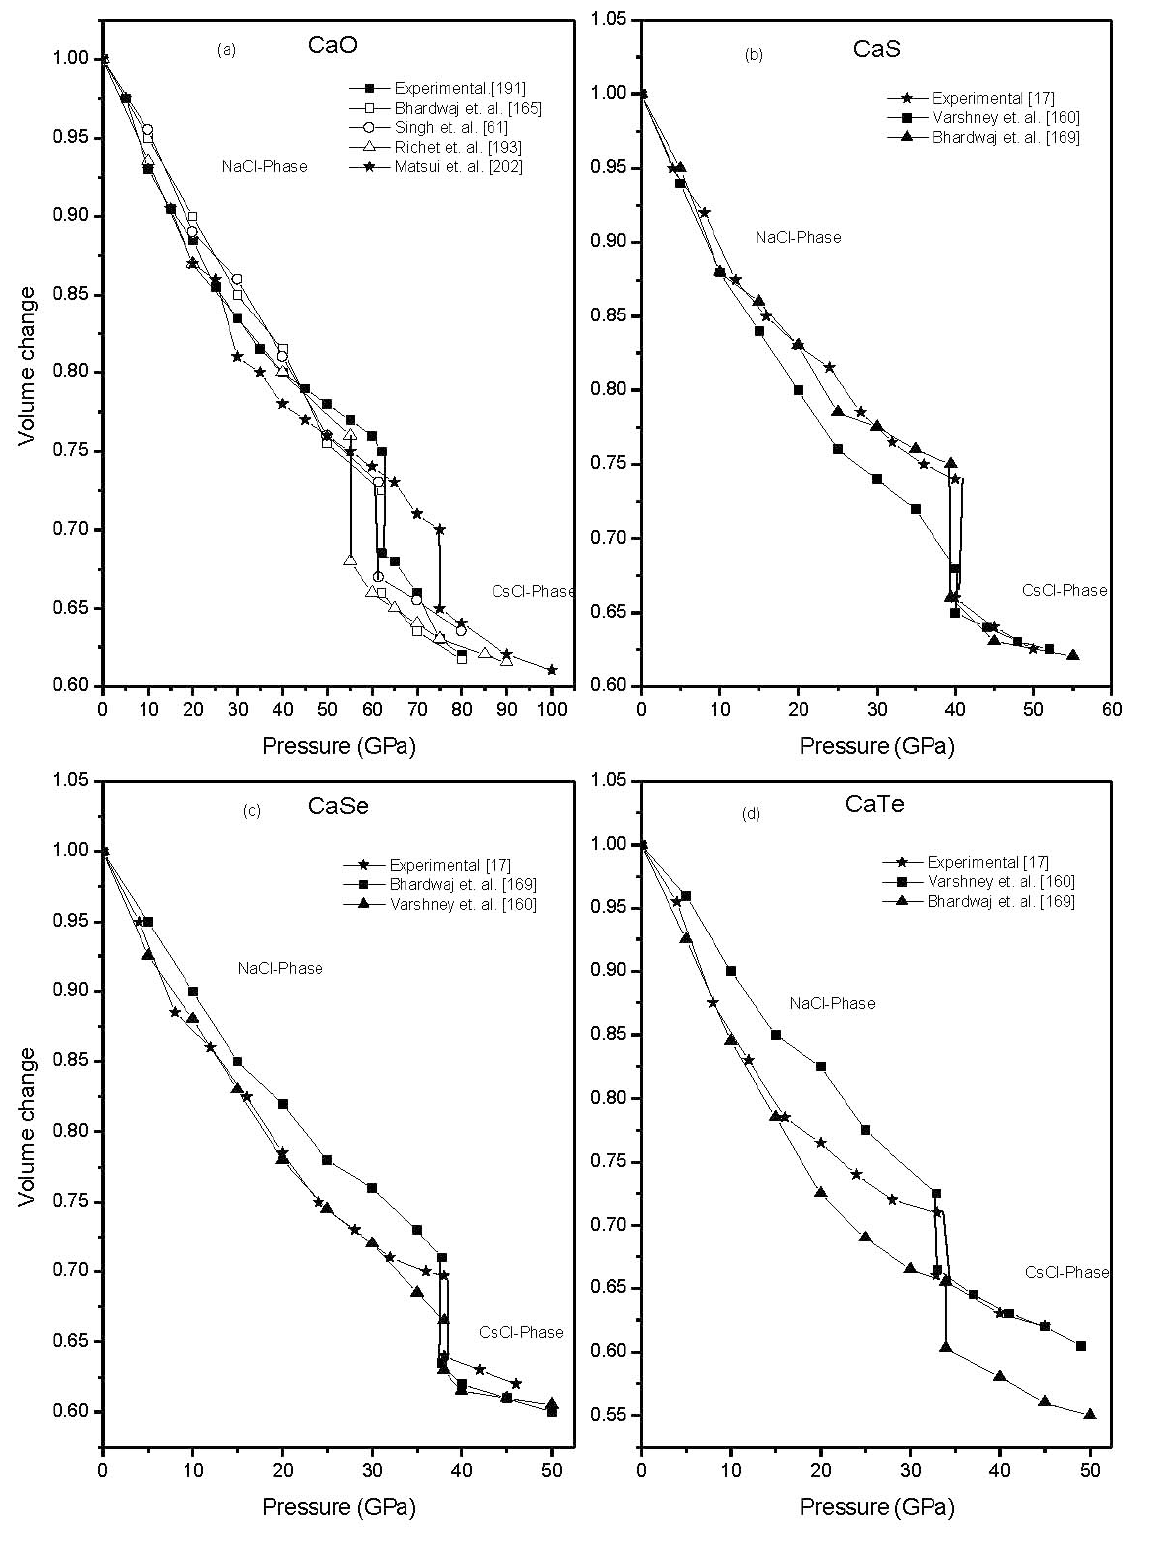
Figure 6. Variation of volume collapse with pressure for calcium